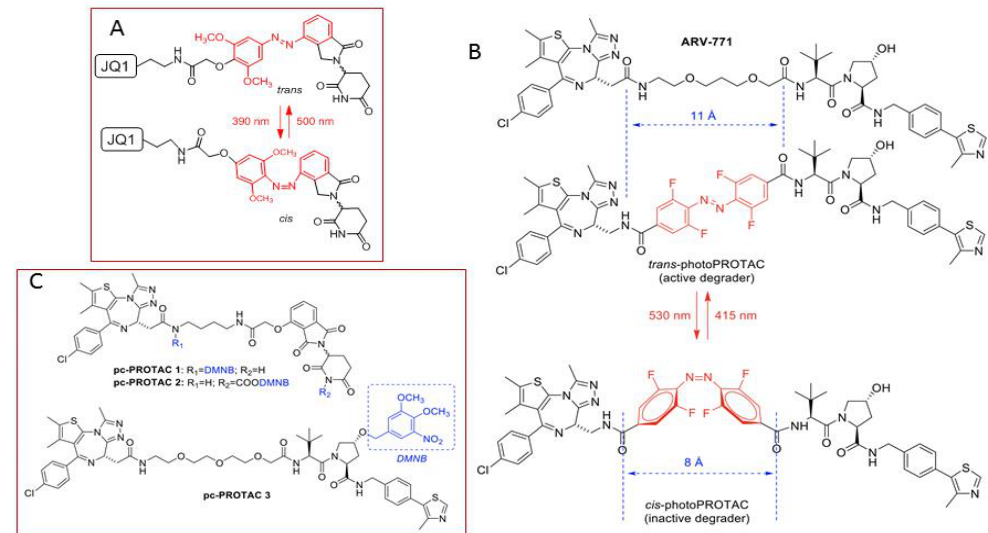
Figure 4. ( A ) Photac targeting the BET family of epigenetic readers BRD2-4. The photoswitchable azobenzene unit is marked in red. ( B ) Canonical protac ARV-771 and its photocontrolled version, showing the trans-cis isomerization between active and inactive states. ( C ) Photocaged variants of protacs developed as Brd4 degraders. In all cases, a DMNB group (in blue) is used as a phototrigger.